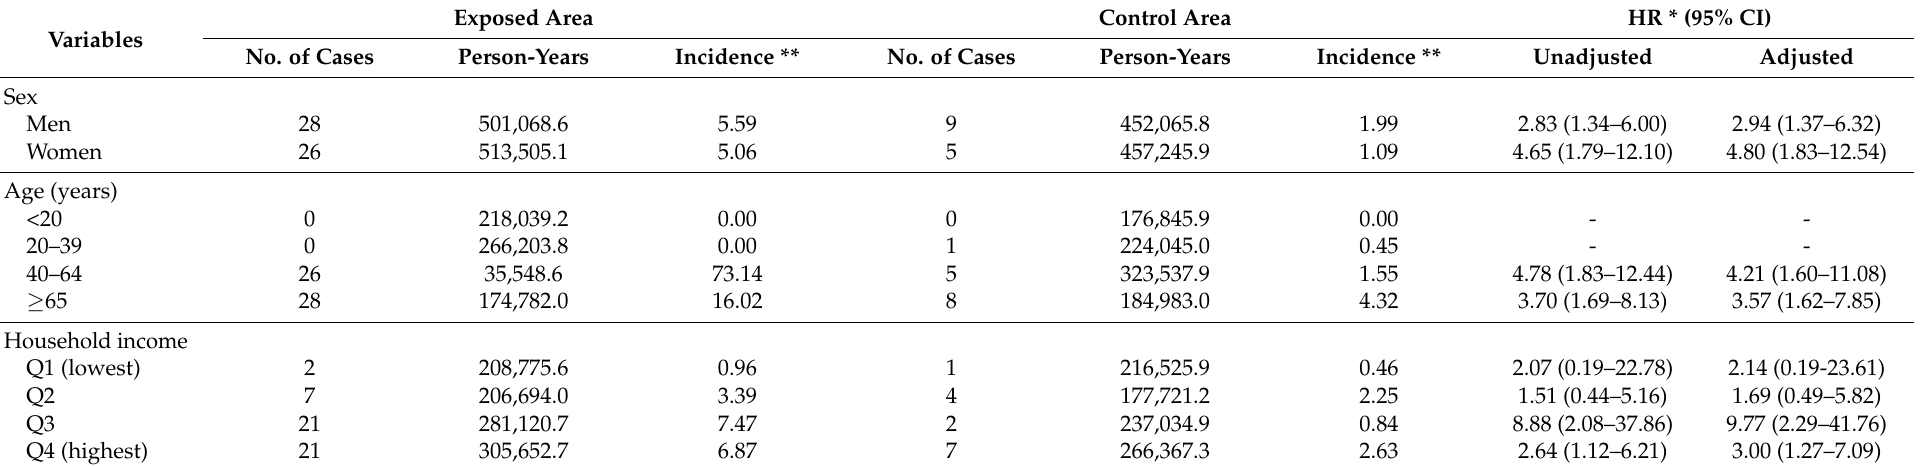
Table 5. Incidence rates and hazard ratios of pleural plaques stratified by sex, age, and household